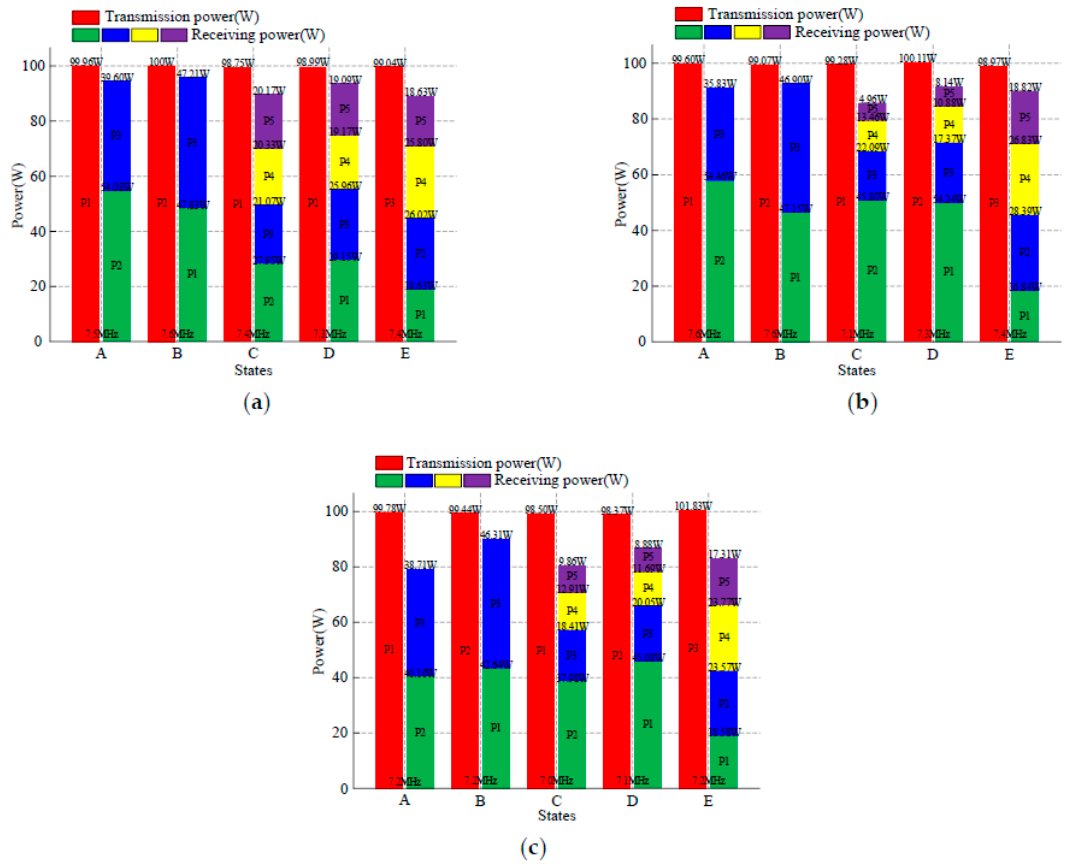
Figure 7. Specific values of transmitting and receiving power of chained systems, transmission distances are ( a ) 2 m, ( b ) 5 m and ( c ) 10 m.